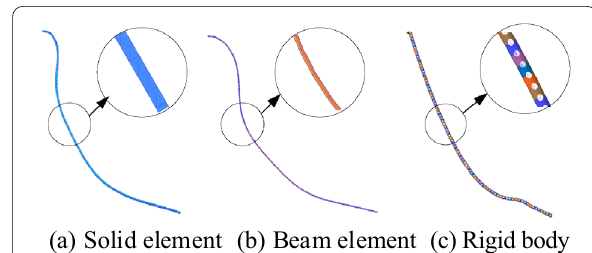
(a) Solid element (b) Beam element (c) Rigid body Figure 3 Modeling methods of flexible